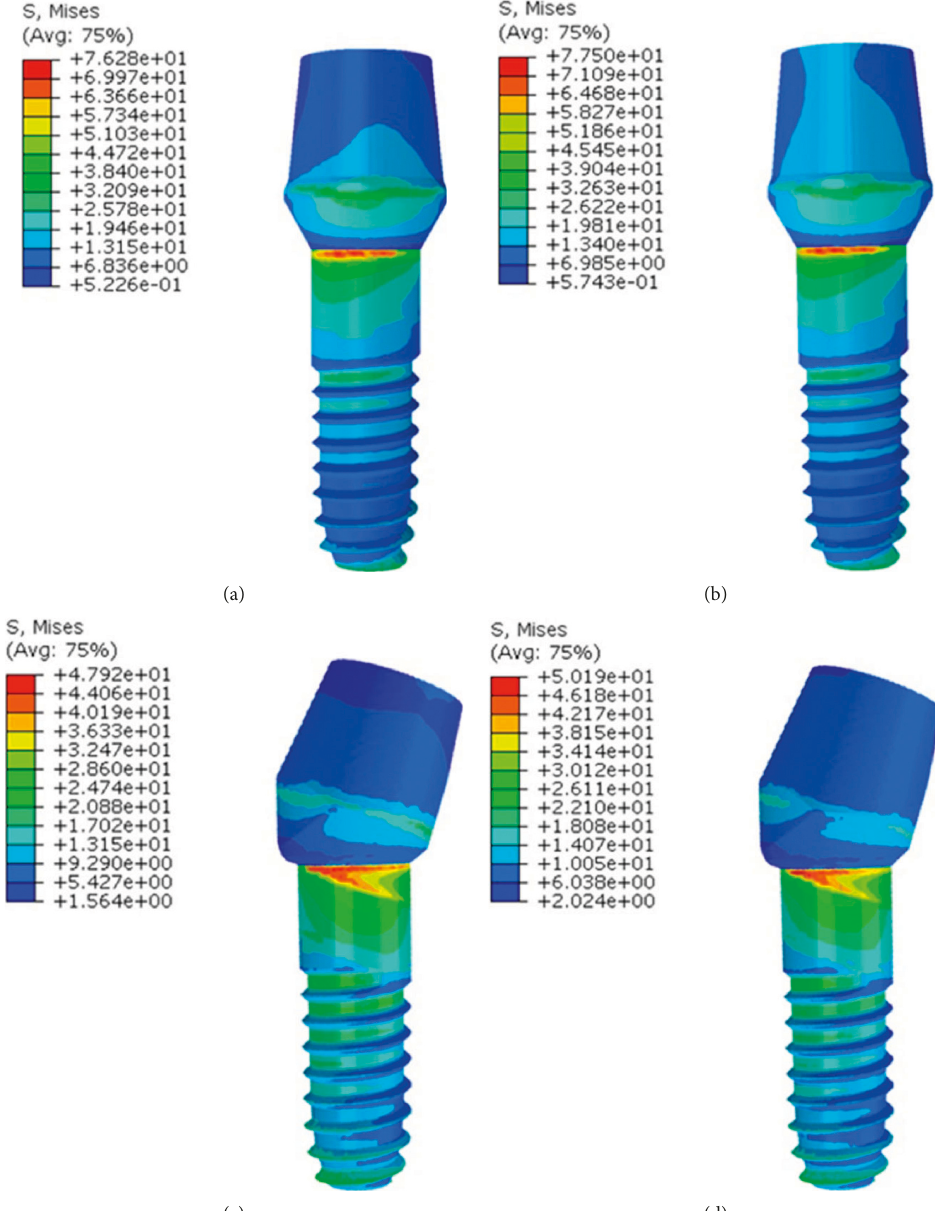
Figure 8: Stress distribution in abutments in model 3. (a), (c) PFBM; (b), (d) PFNM.